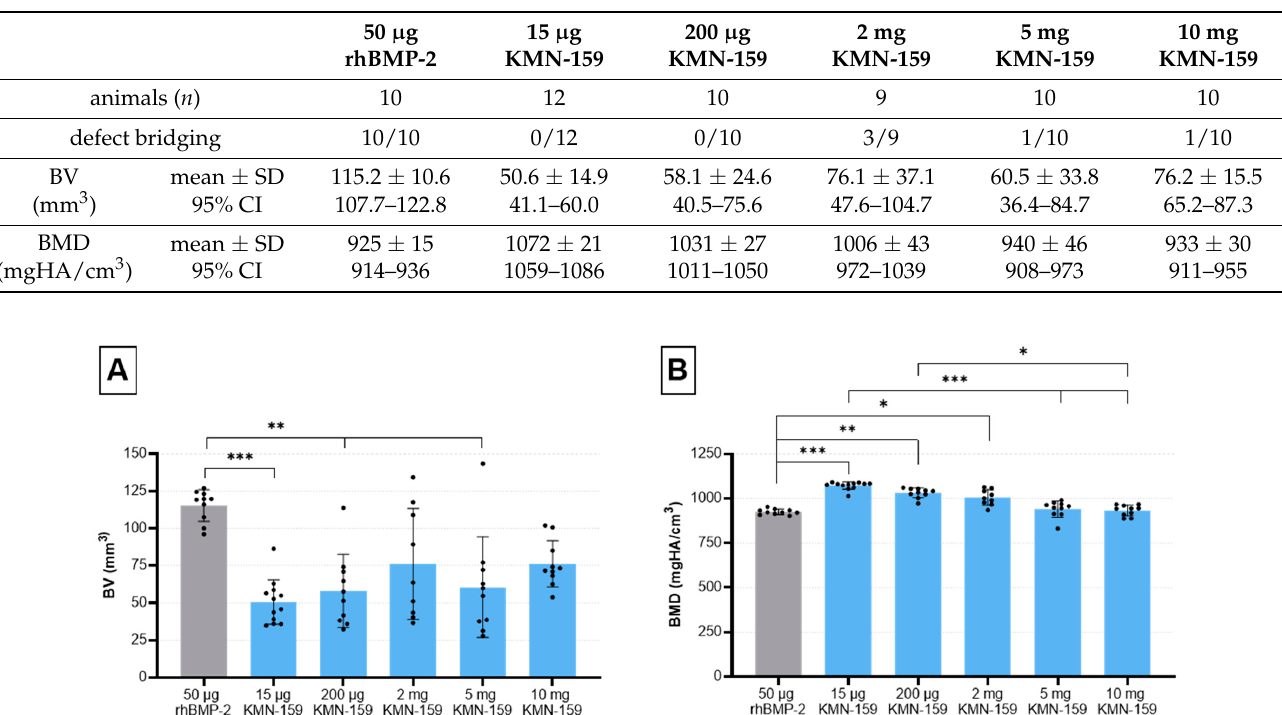
Table 2. Sample size ( n ), defect bridging as well as mean value, standard deviation (SD) and 95% confidence interval (CI) of bone volume (BV) and bone mineral density (BMD) 12 weeks post-surgery as evaluated by µ CT.